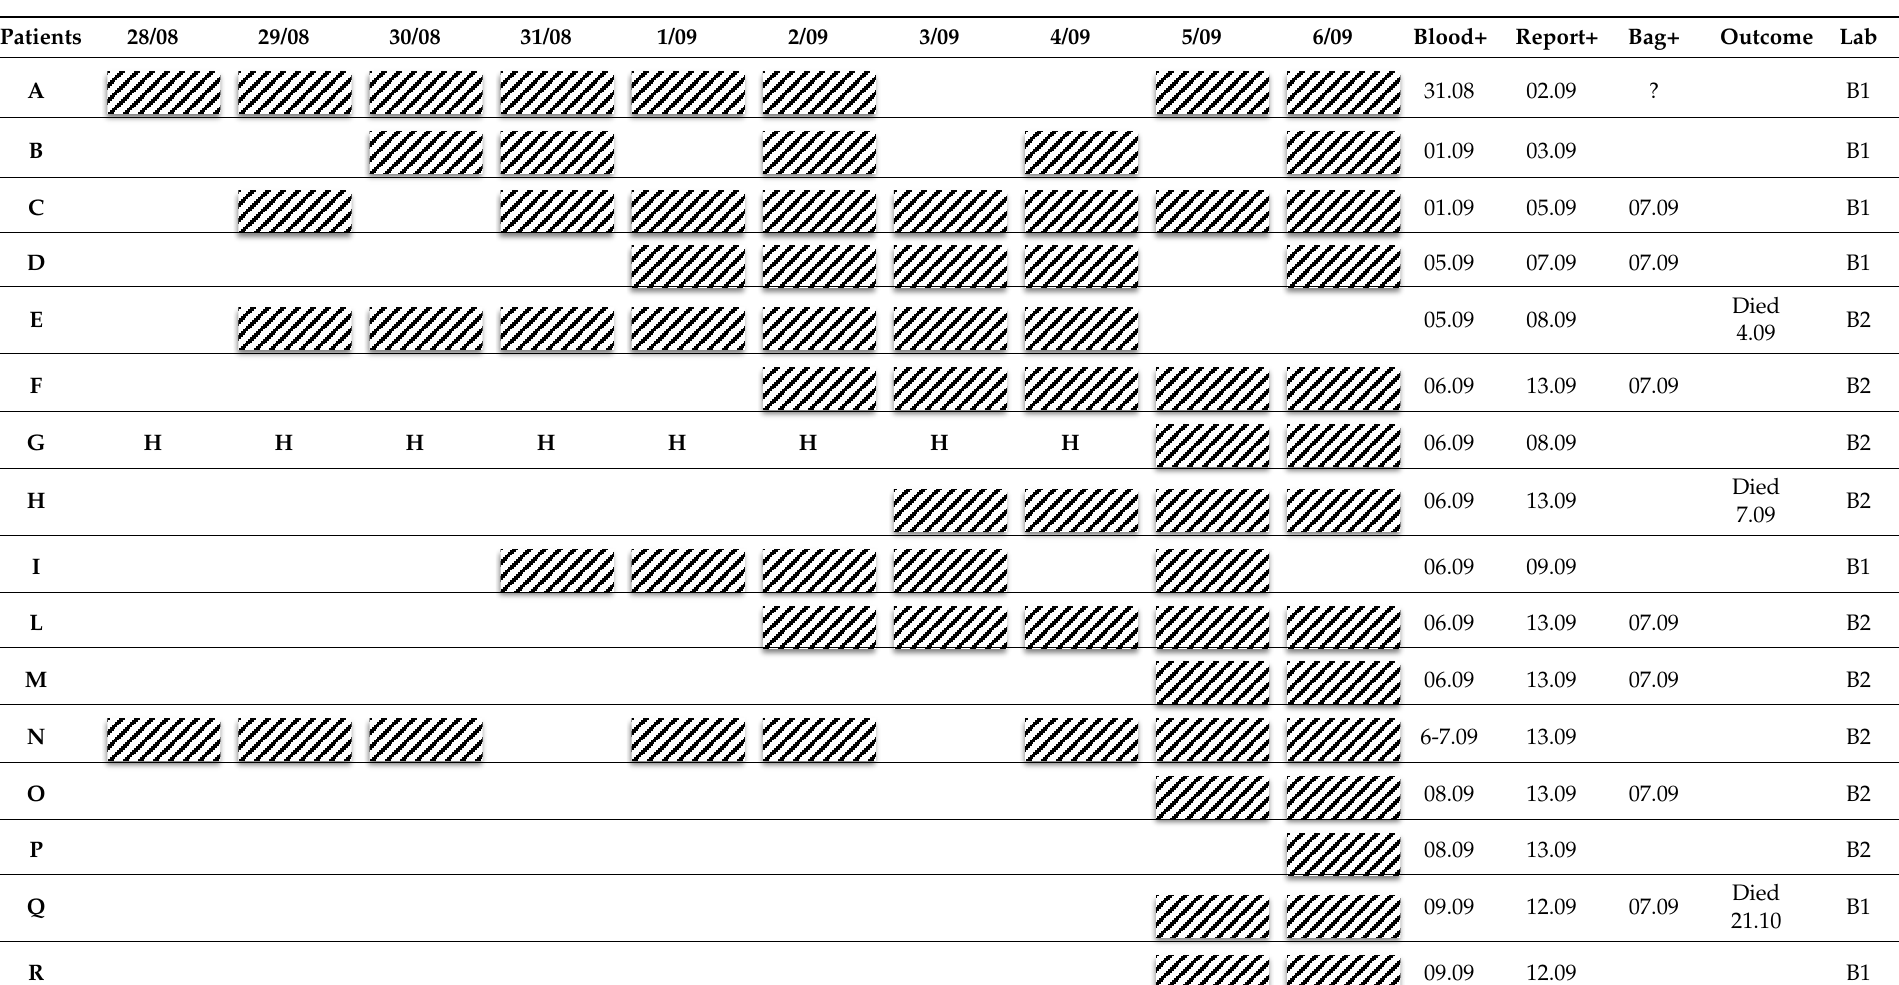
Table 4 summarize the most relevant data for each patient. Table 4. Patients, date of administration of Total Parenteral Nutrition in the hospital (marked with diagonals) or at home (H), date the bloodwork tested positive (blood +), date of the report (report+), date the bag tested positive (bag+), outcome, and laboratory that performed the analyses (B1 = Bacteriology 1, B2 = Bacteriology 2).